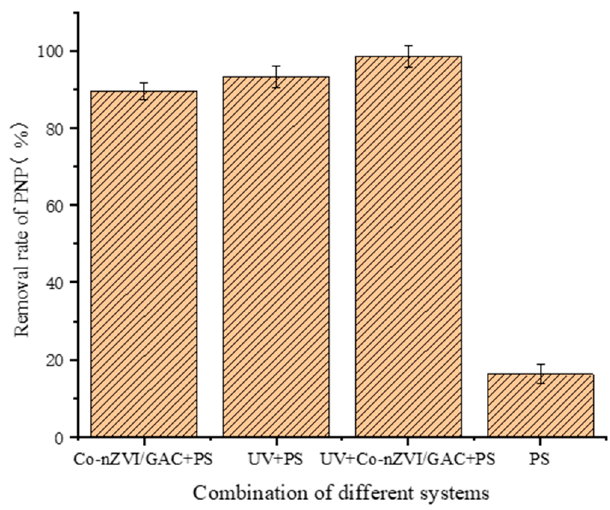
Figure 4. Degradation effects of different systems on PNP removal.